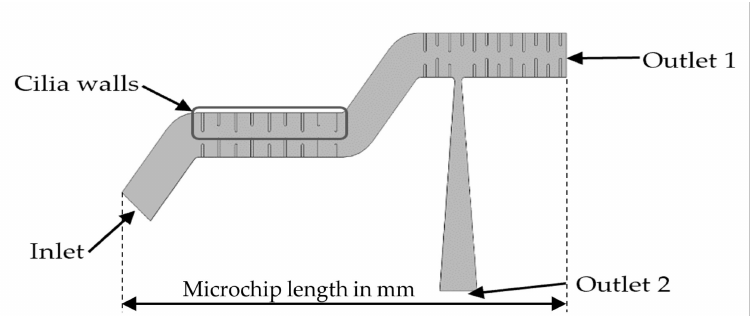
Figure 6. Design of microchips with cilia